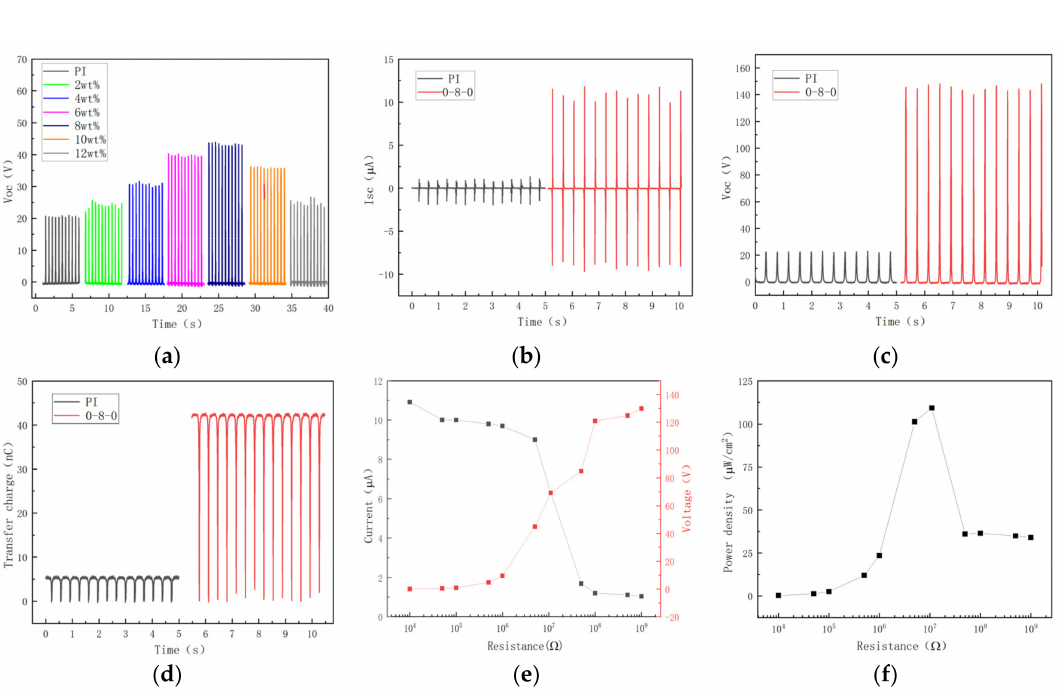
Figure 9. Output performances of the CS-TENG. ( a ) Variation in open-circuit voltage with doping mass fraction. ( b ) Short-circuit current (I SC ). ( c ) Open-circuit voltage (V OC ). ( d ) Transferred charge of PI and 0-8-0. ( e ) Current and voltage and ( f ) power density of